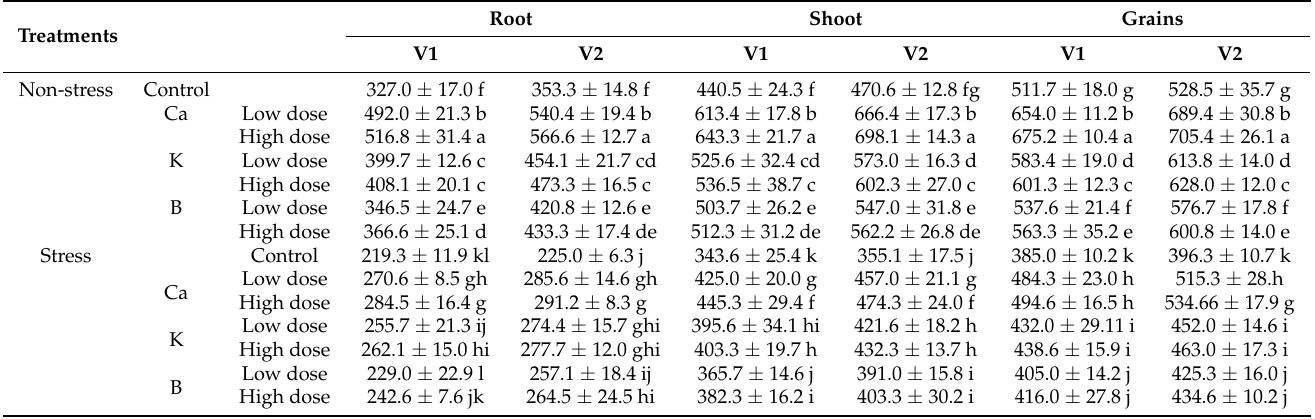
Table 2. Analysis of Ca content in the root, shoot, and grains of durum wheat. Different letters shows significant difference among the treatments. Standard error was calculated by using the replicates.